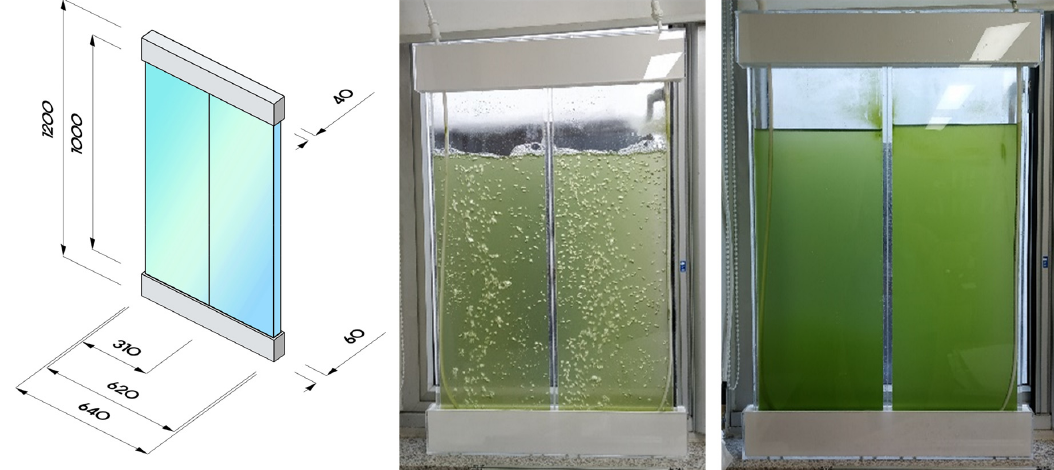
Figure 3. Test specimen of microalgae façade (Adapted from Ref. [26]).